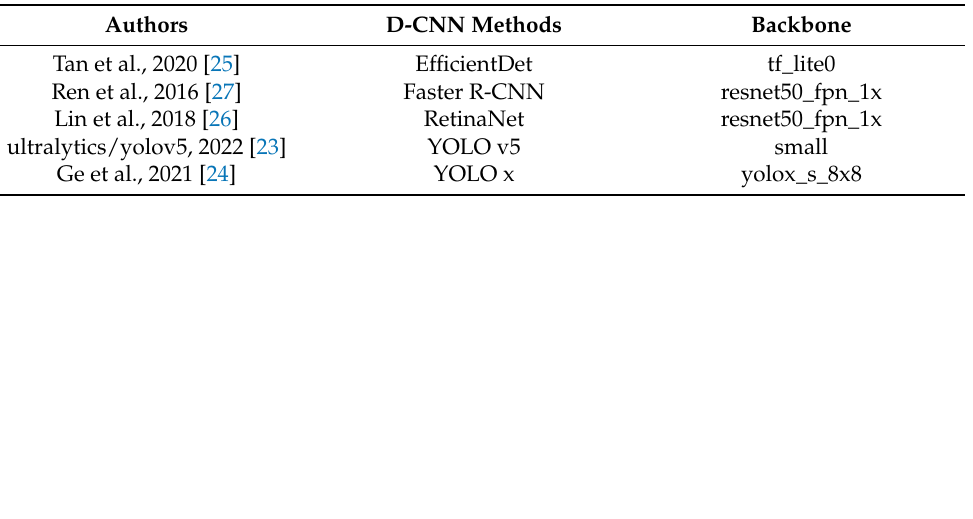
Table 4. Pretrained backbone network architectures used for D-CNN